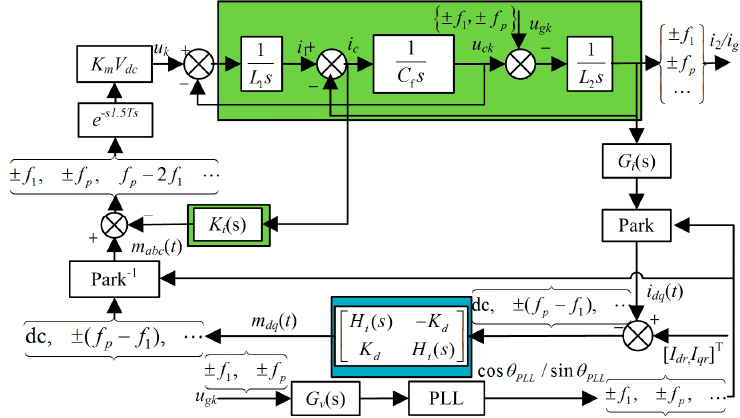
Figure 4. Signal flow diagram of inverter with dq -domain GC feedback control during positive-sequence perturbation.